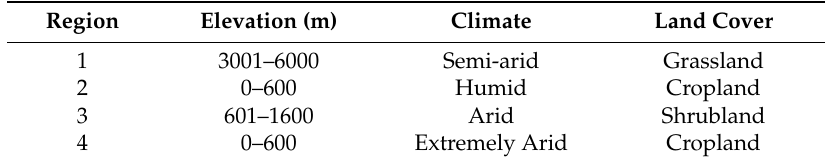
Table 1. Description of the regional elevation, climate class and land cover of the four regions selected for comparison of GPPs and in-situ observations as shown in Figure